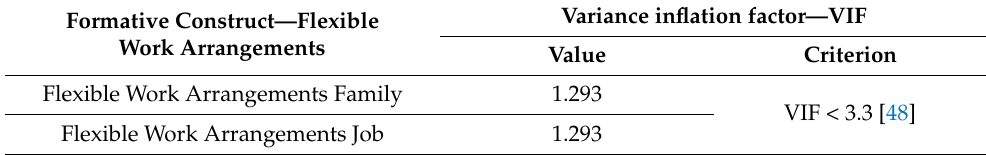
Table 6. Variance inflation